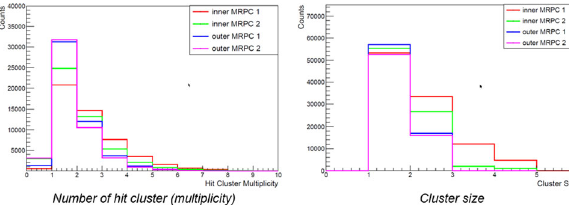
Fig. 19 Number of hit cluster and cluster size of the MRPC at beam time